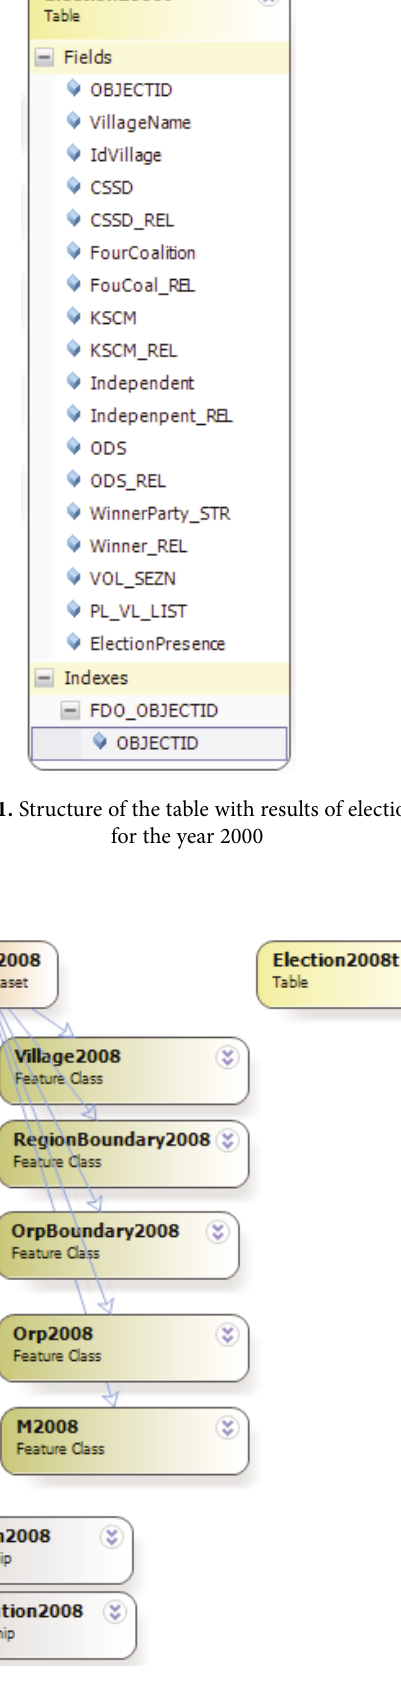
Fig. 2. The structure of “Election2008”